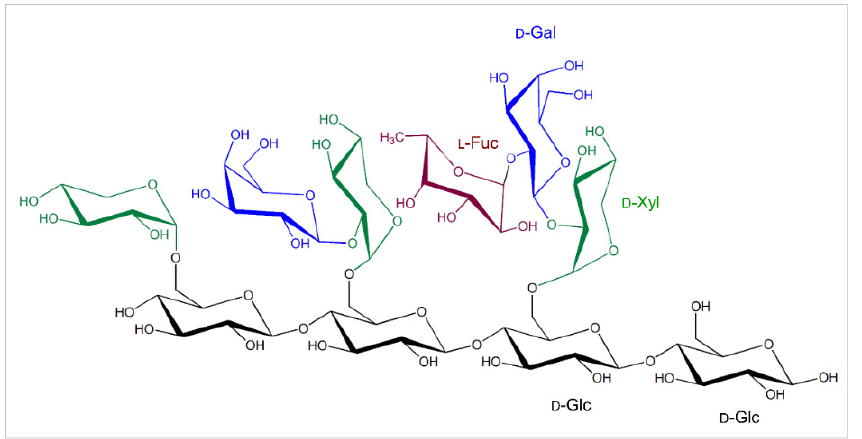
Figure 1. The common substitutions in the tetragluco-oligosaccharide unit of XGs that forms chains of repeating (1,4)- β - D -linked glucopyranosyl residues (black), with the C-6 carbons carrying α - D - xylopyranosyl moieties (green), which could be substituted by galactopyranosyl residues (blue) on the C-2 carbons ( β - D -Galp-(1,2)- α - D -Xylp). The galactopyranosyl residues could carry fucopyranosyl residues (brown) on the C-2 carbons ( α - L -Fucp-(1,2)- β - D -Galp-(1,2)- α - D -Xylp). Descriptions of sugar moieties are indicated in matching colours.